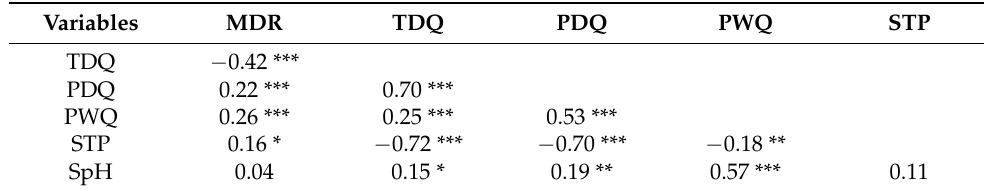
Table 1. Correlations between environmental variables. Significance levels: *, p < 0.05; **, p < 0.01; ***, p <